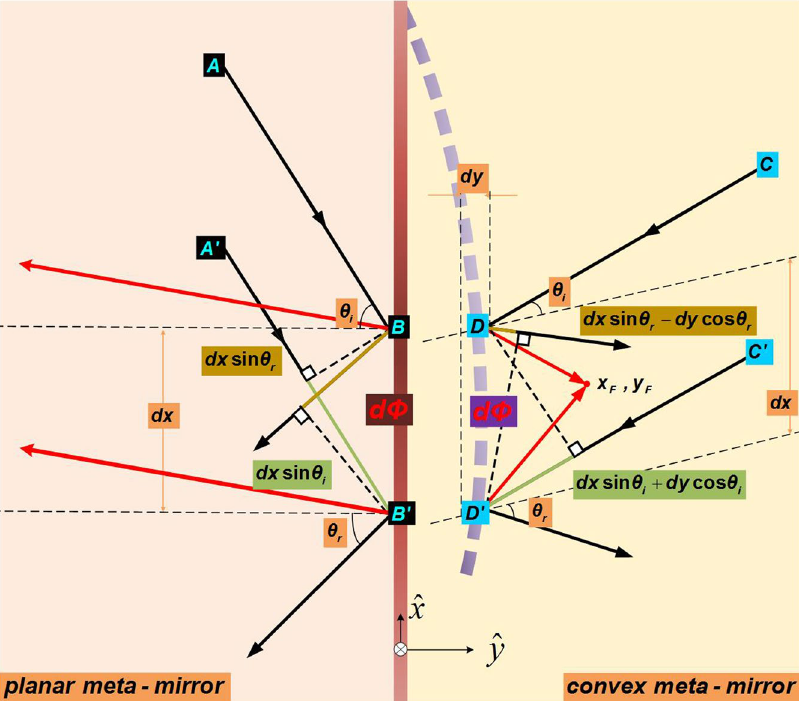
Figure 1. Design principle of the planar meta-mirror BB ′ and the convex meta-mirror DD ′ . B and B ′ on the planar meta-mirror are very closed to each other in positions with small variations of dx . D and D ′ on the convex meta-mirror are very closed to each other in positions with small variations of dx and dy . d Φ refers to the phase variation between these two poisons of B ( D ) and B ′ ( D ′ ) on the meta-mirrors. The black rays refer the incidences and the normal behavior of the positive reflections. The red rays refer to the negative